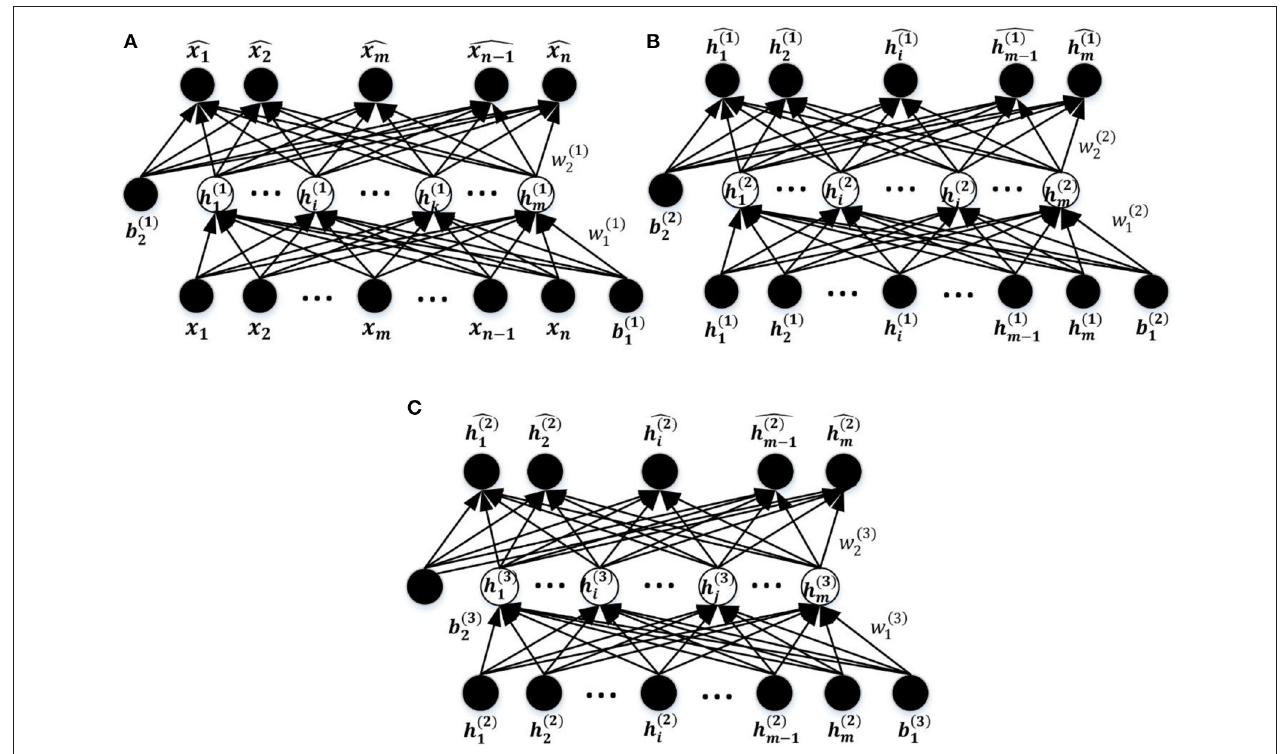
FIGURE 5 | The process of layer-wise training the stacked SAEs. (A) The first SAE. (B) The second SAE. (C) The Third SAE.